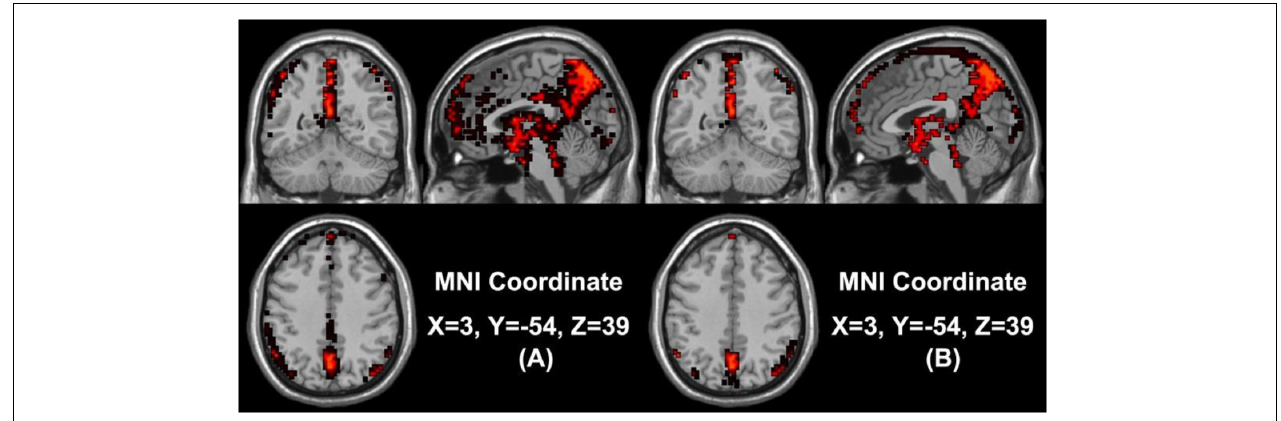
FIGURE 1 | (A) The spatial brain maps of activated voxels in the non-seafarer group. (B) The spatial brain map of activated voxels in the seafarer group. The red represents the common activated regions of the non-seafarer and seafarer groups, and the black represents the individually activated regions of each group.